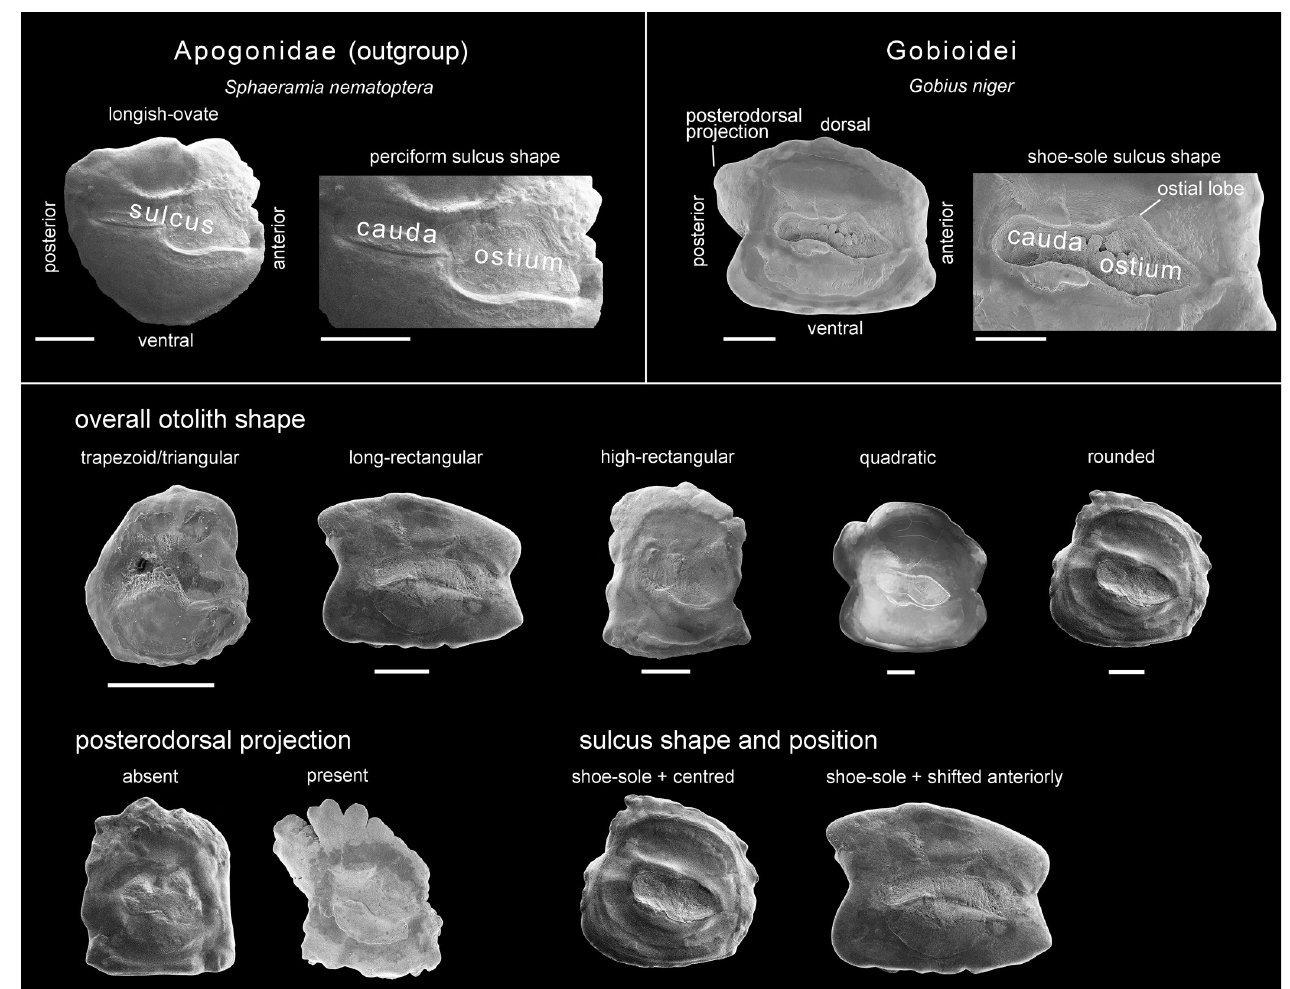
Fig 2. Otolith terminology and otolith characters and character states used here for the phylogenetic analyses. Images depict left otoliths (sagittae) in medial view. Scale bars: 0.5 mm.